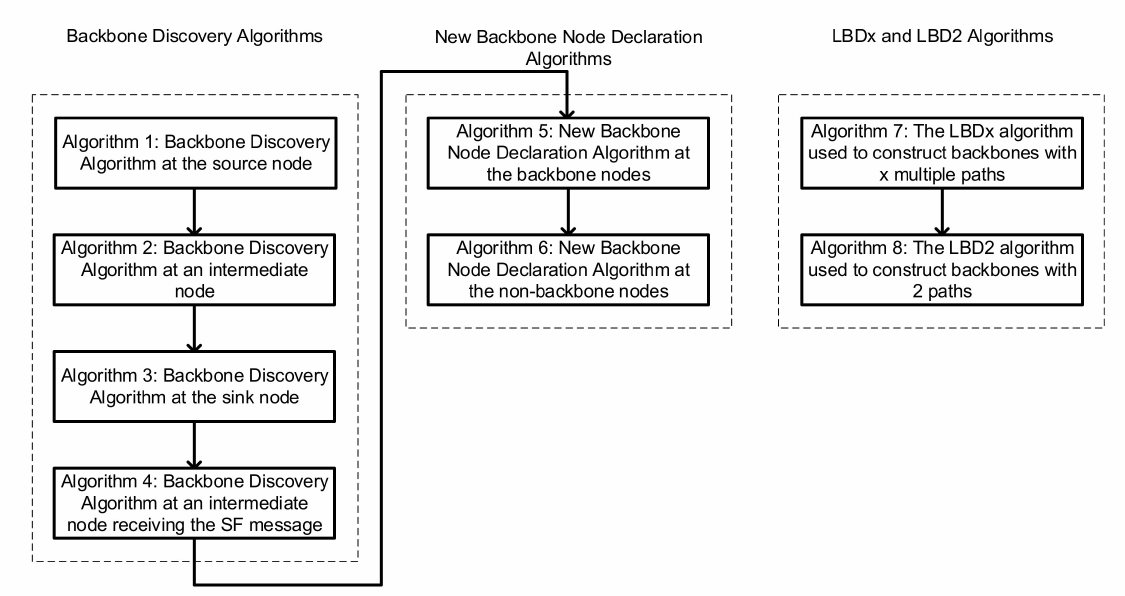
Figure 4. Flowchart showing the sequence of execution and relationship of the various